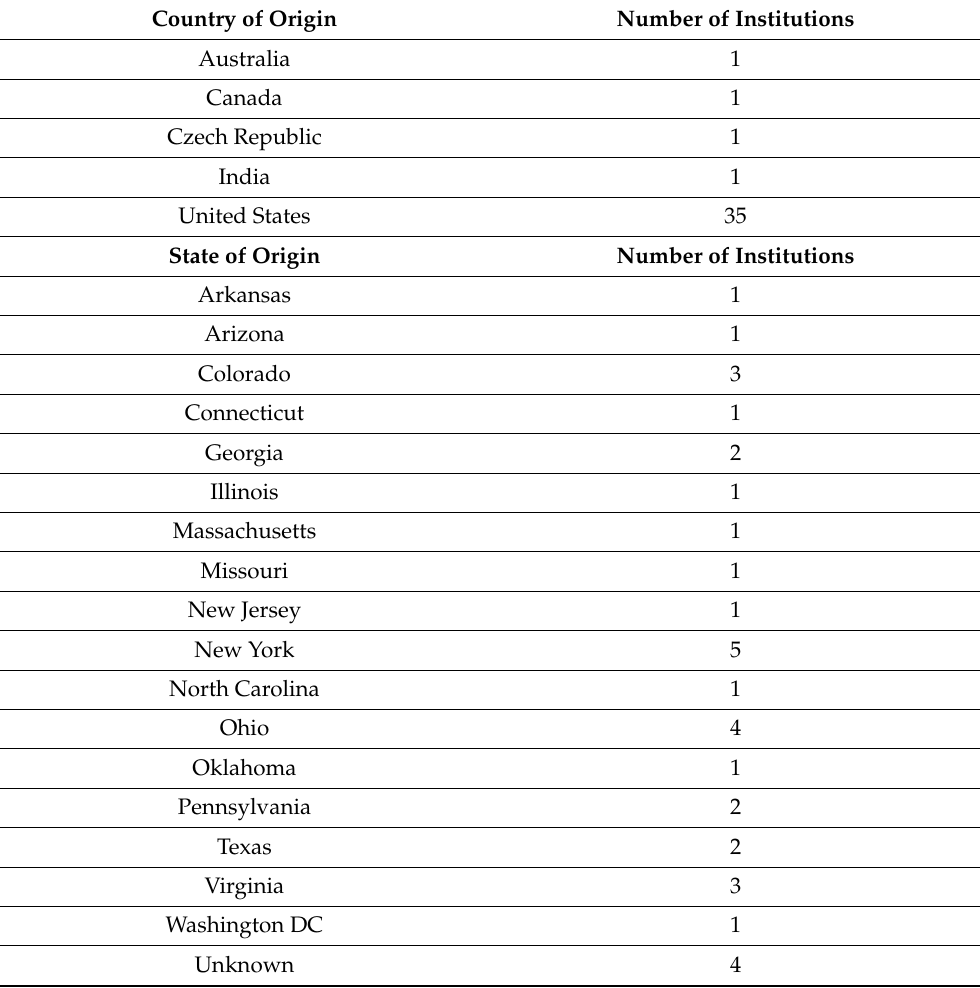
Table 2. Geographic distribution of